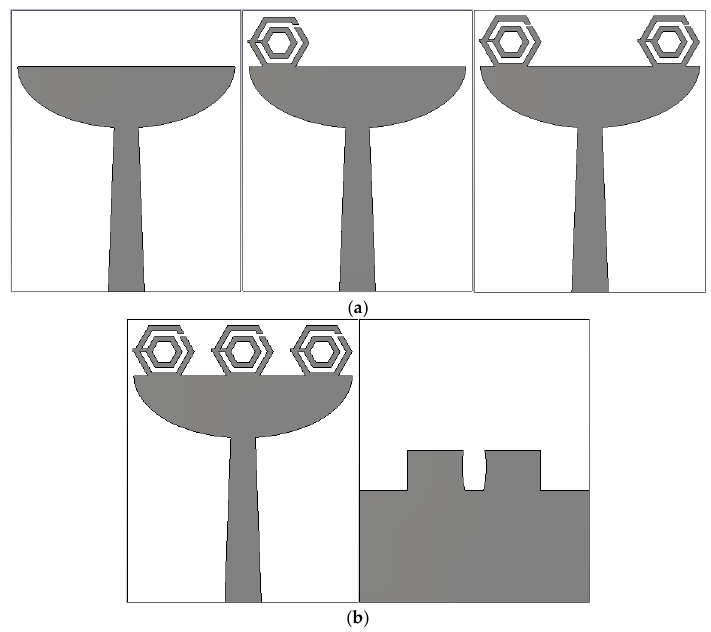
Figure 4. Ultrawideband (UWB) metamaterial antenna with ( a ) design evolution and ( b ) final design.